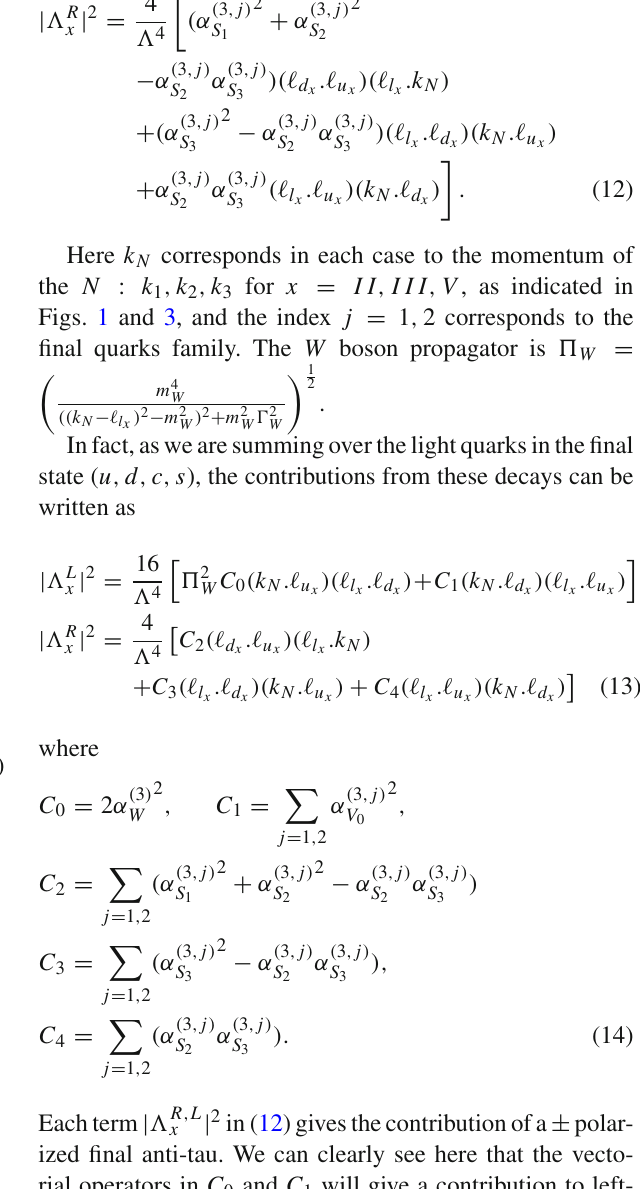
Fig. 4 Diagrams contributing to the decay process N → (cid:13) +